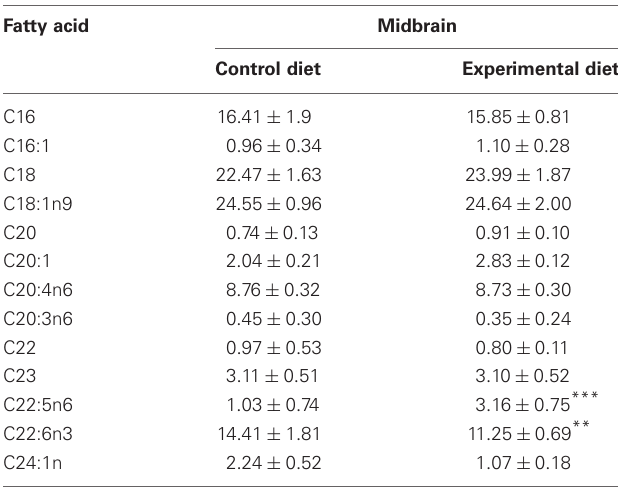
Table 4 | Fatty acid composition (% of total) in midbrain phospholipids of F1 generation groups raised on Control or Experimental diets.